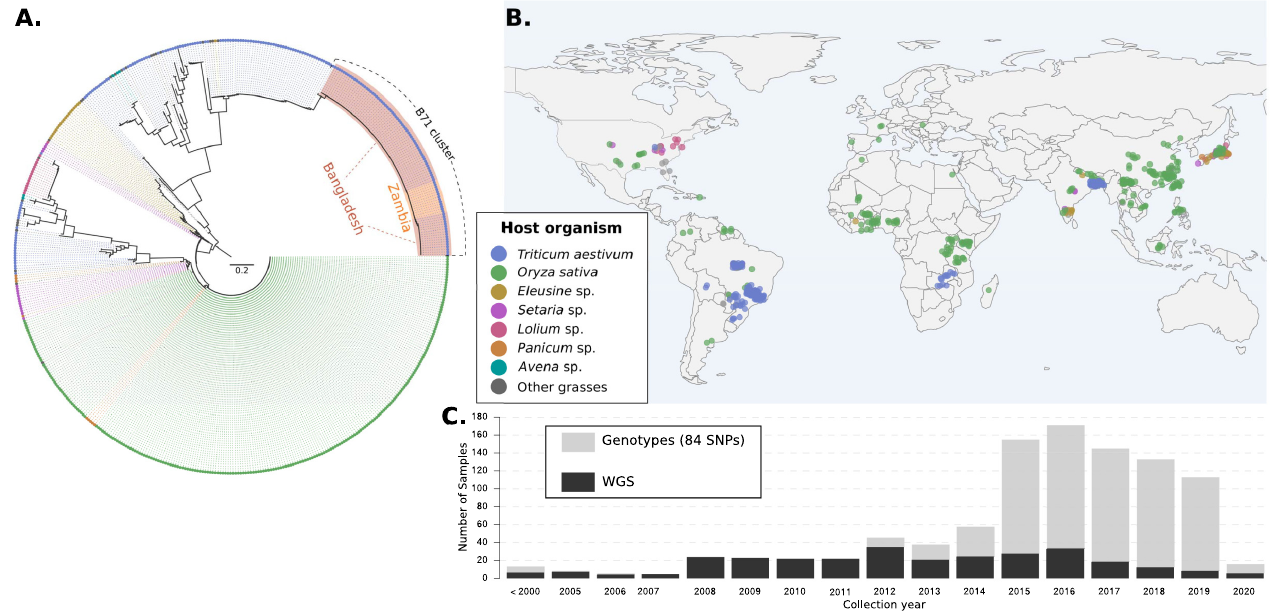
Fig 1. The emergence of wheat blast in Bangladesh and Zambia was caused by the B71 genetic lineage of Magnaporthe oryzae . (A) Neighbor-joining tree of 537 worldwide distributed M . oryzae isolates based on 84 concatenated SNPs obtained by multiplex amplicon sequence and/or genome sequences. The topology corresponds to the optimal tree drawn from 1,000 bootstrap replicates. Isolates that belong to the B71 lineage are shown with orange (13 Zambian isolates) and red (71 Bangladeshi isolates and the Bolivian B71) background shades. (B) Geographical distribution of M . oryzae samples used in the tree. The colored points represent the approximate geographical origin of the isolates. Colors in (A) and (B) correspond to the plant host organism (upper inset). The base map was created with the R package rworldmap v . 1 . 3 . 4(data from : Natural Earth data v . 1 . 4 . 0) . (C) Distribution of the collection year of M . oryzae wheat- infecting isolates used in the phylogenetic analysis. The data underlying this figure can be found in https://doi.org/10.5281/zenodo.7590238. SNP, single nucleotide